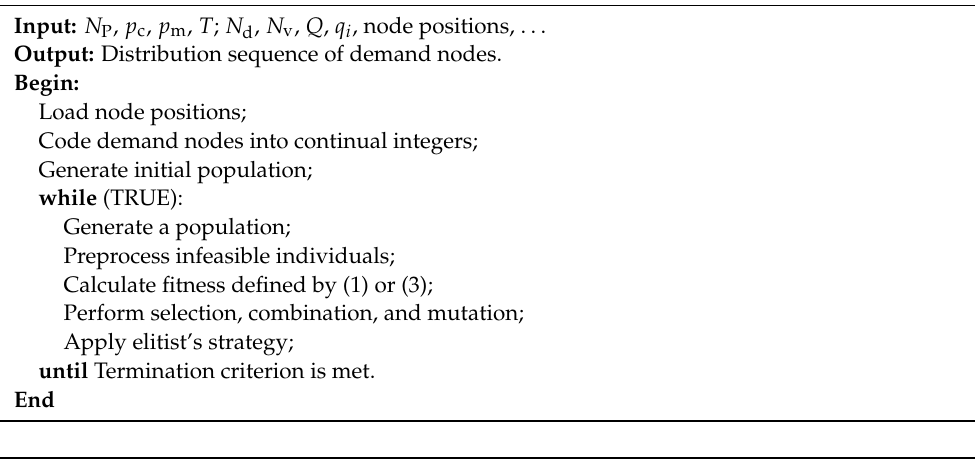
Algorithm 2 [Route Search Between Two